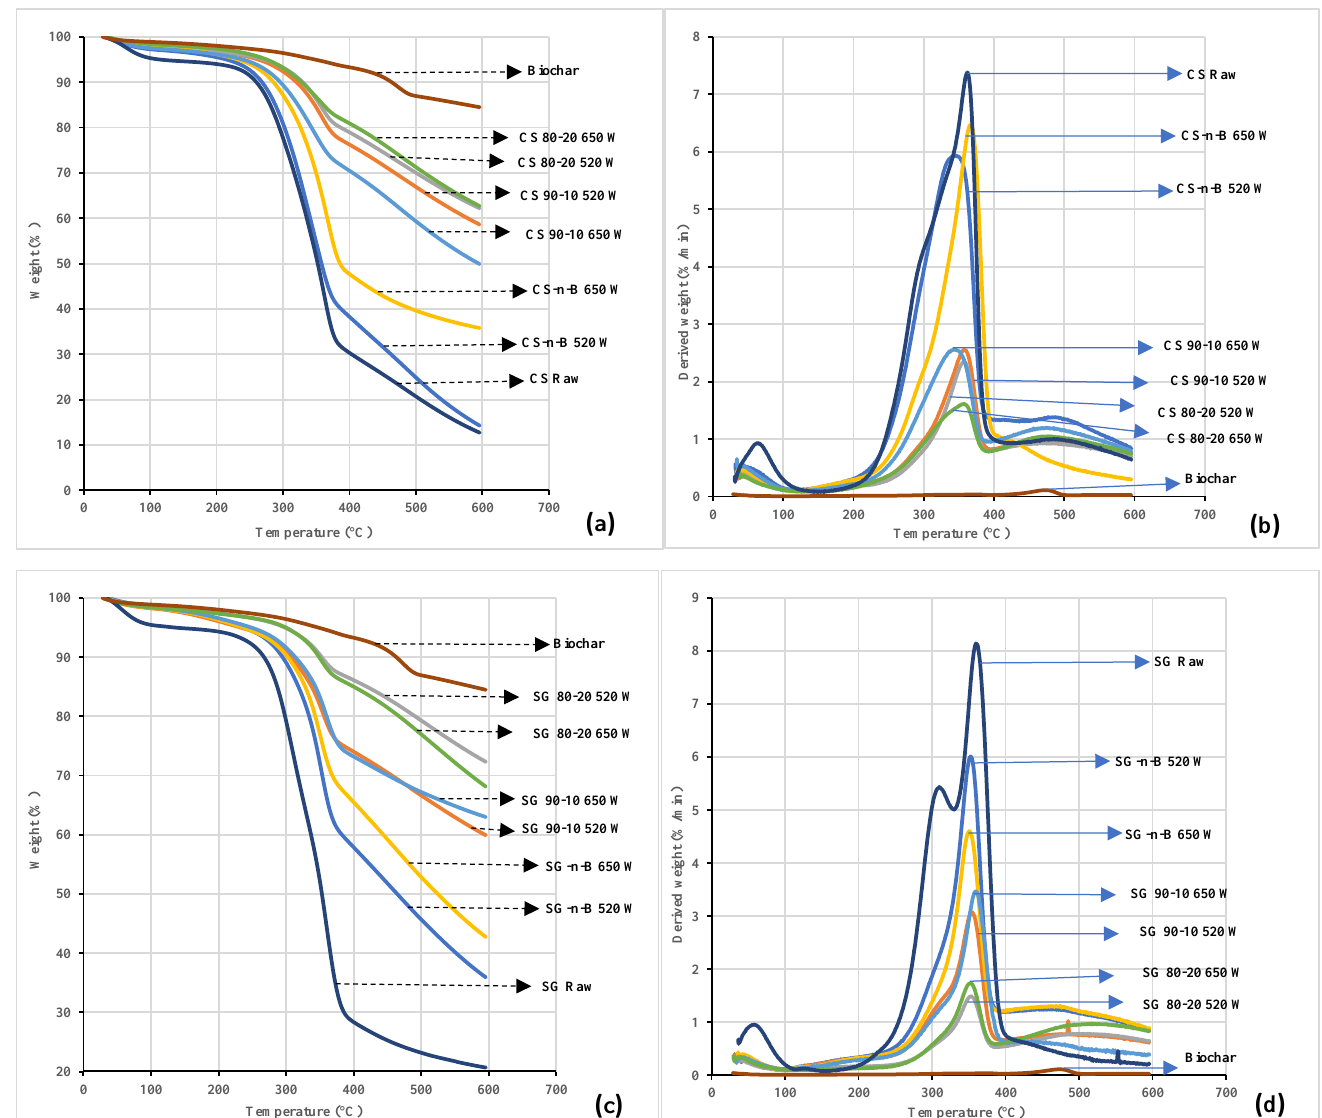
Figure 10. Thermogravimetric curves of raw and torrefied camelina straw and switchgrass with biochar-mix at 20 min residence time ( a ) TGA of CS, ( b ) DTG analyses of CS, ( c ) TGA of SG, ( d ) DTG analyses of SG. CS: camelina straw; CS-n-B: camelina straw-no-biochar; SG: Switchgrass; SG-n-B: Switchgrass-no-biochar The first number after the biomass is % of biomass, and the second number is % of bio- char.